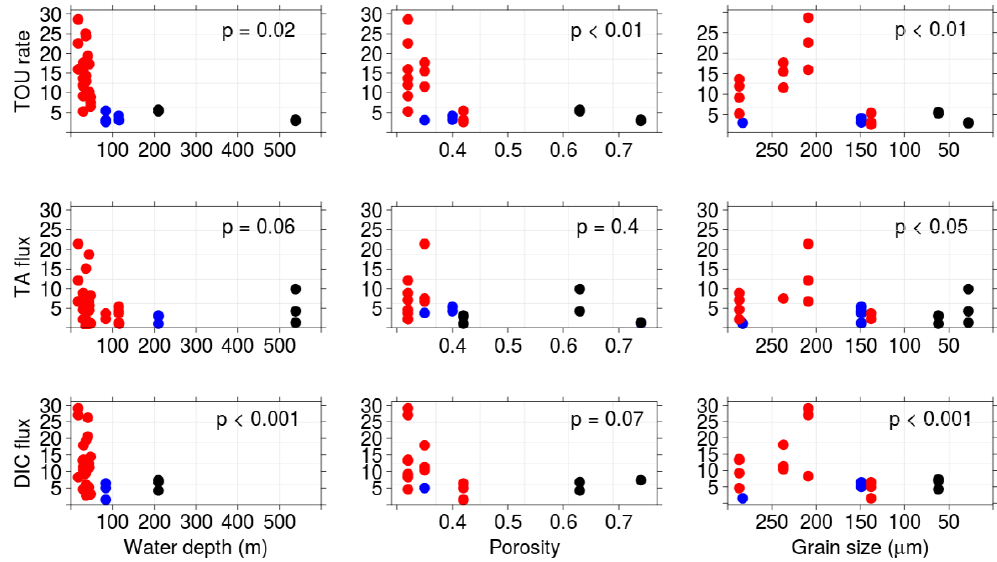
Figure 6. Correlation plots between DIC fluxes, A T fluxes, TOU rates and water depth, porosity and grain size. Red: SNS; black: SKNT; blue: NNS. Spearman’s p value given in each plot. Units mmolCm − 2 d − 1 (DIC), mmolm − 2 d − 1 ( A T ), and mmolO 2 m − 2 d − 1